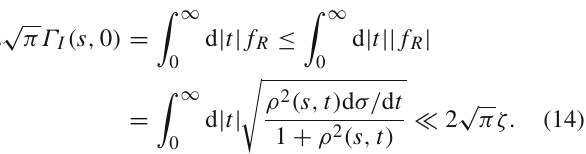
much smaller decline from 1 for small (cid:15) . The elastic profile, equal to ζ 2 in central collisions, also reaches the value 1 for ζ = 1. Namely the point b = 0 happens to be most sensitive to the variations of ζ in different